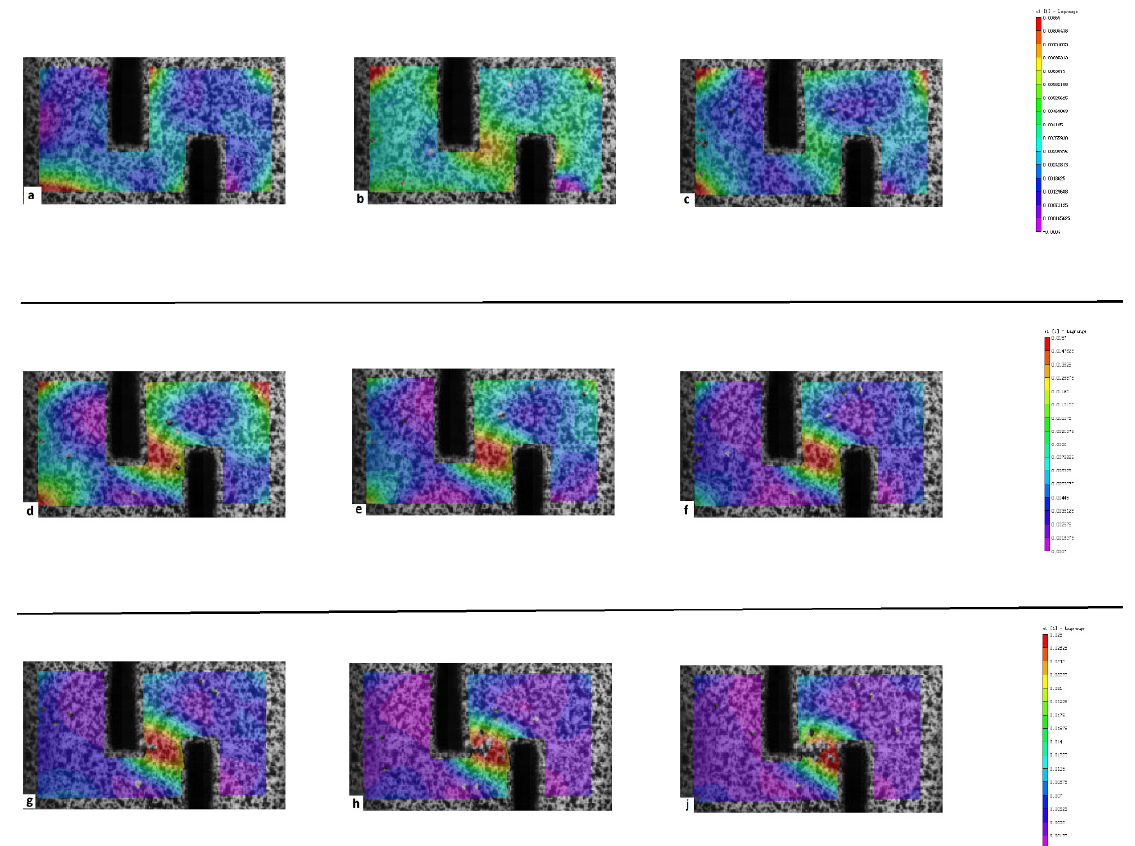
Figure 13. Maximum shear strain fields of the NSSS at di ff erent times during dynamic loading ( a ) 0 µ s, ( b ) 6.6 µ s, ( c ) 13.2 µ s, ( d ) 19.8 µ s, ( e ) 26.4 µ s, ( f ) 33 µ s, ( g ) 39.6 µ s, ( h ) 46.2 µ s, and ( j ) 52.8 µ